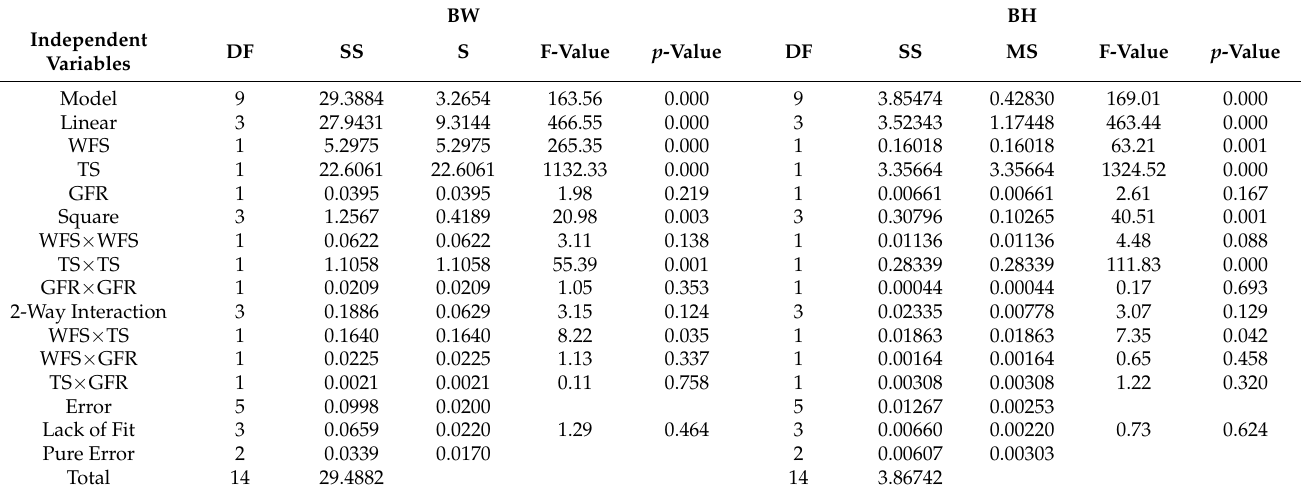
Table 5. The Anova results related to the mathematical model developed using the RSM approach. BW BH